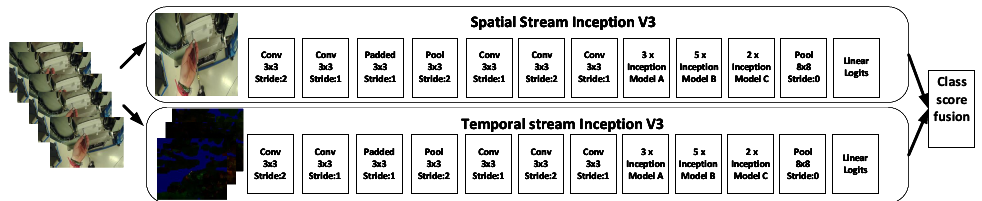
Figure 6. Two-stream model which shows the parallel working on two different types of inputs and combining them at the